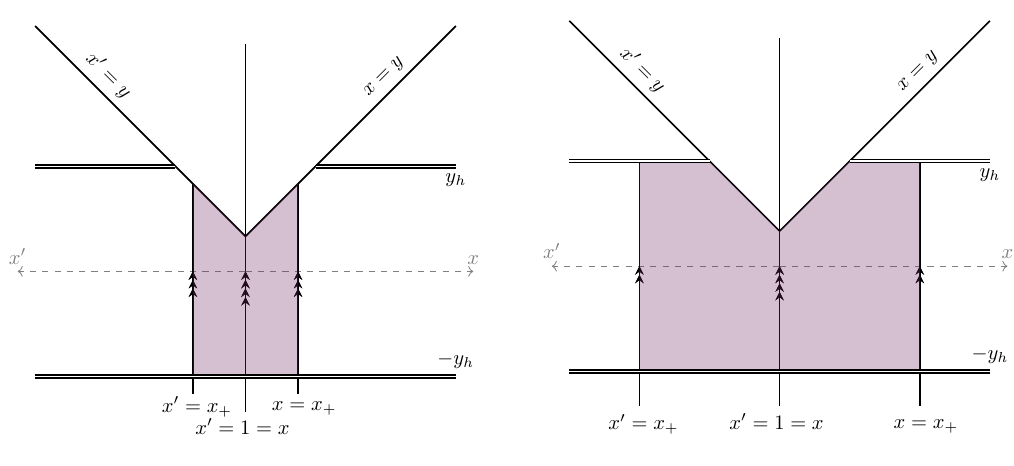
Figure 13 . Left : II right,slow . The two patches of type II spacetime — with x > 1 — and the identifications used to construct a black hole accelerated by a pushing strut when x + < y h . Right : II right,rapid . The two patches of type II spacetime — with x > 1 — and the identifications used to construct a black hole accelerated by a pushing strut when x + > y h